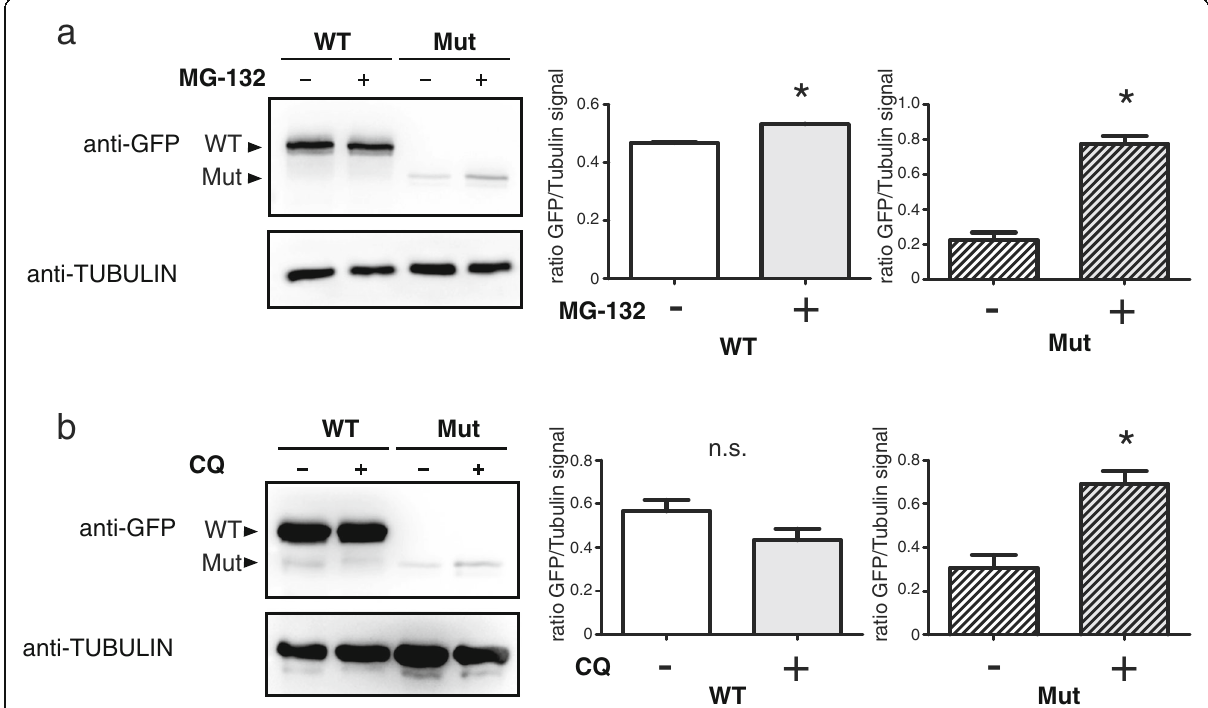
Fig. 5 To analyse the impact of the patient mutation on the protein level, HEK293T cells expressing FLCN WT or Mut fused to GFP using the TALEN technology were generated. a and b Western blot analyses reveals that the mutant protein is hardly expressed. This could in part be alleviated with MG-132 ( a , treatment with 10 μ M for 2 h) or chloroquine ( b , treatment with 50 μ M for 24 h), indicating an involvement of the proteasome and lysosome in the degradation process. Tubulin served as loading control ( p =3, error bars indicate SEM, * = p < 0.05, n.s. = not significant, two tailed t